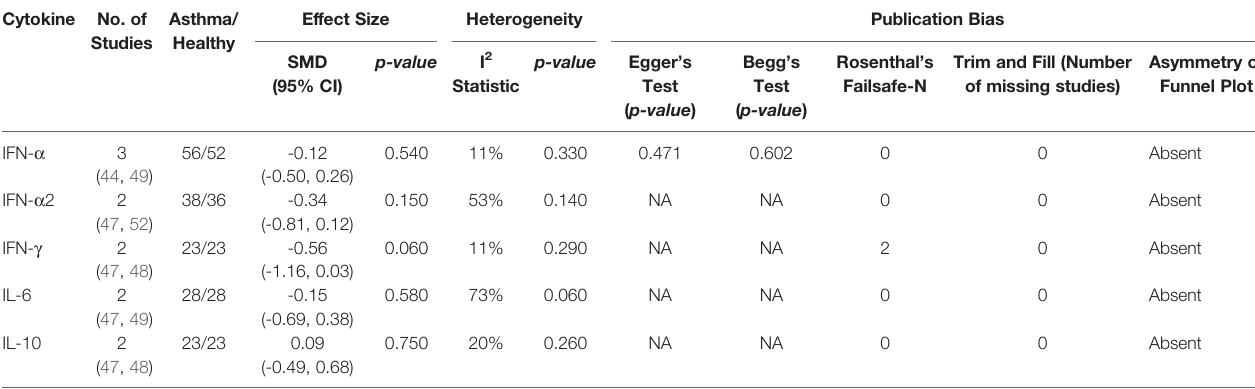
TABLE 6 | Summary of meta-analysis of ex vivo PBMCs studies comparing RV-induced cytokine responses in adults with atopic asthma vs non-atopic healthy controls. Cytokine No. of Asthma/ Studies Healthy